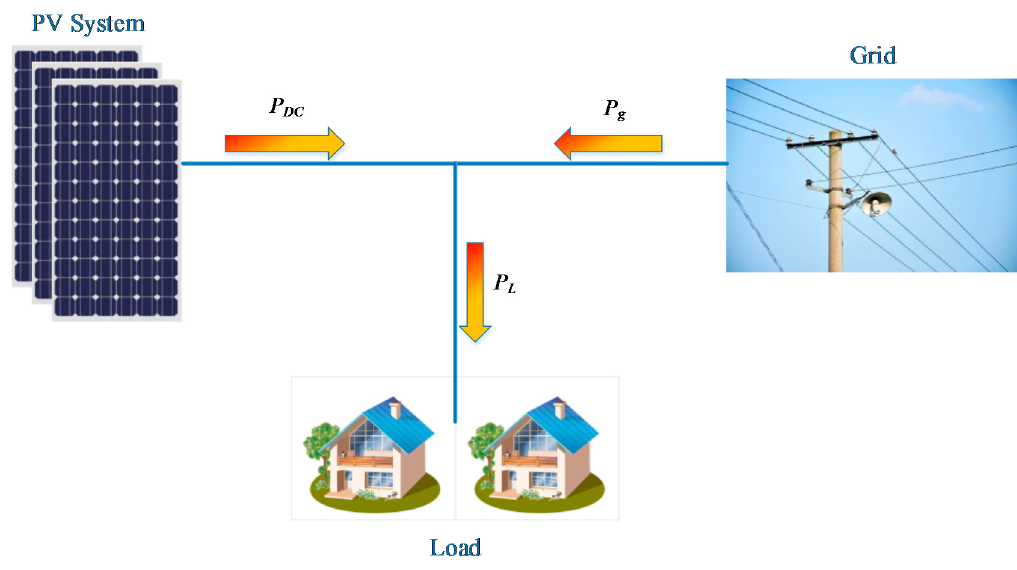
Figure 1. Simplified power system.